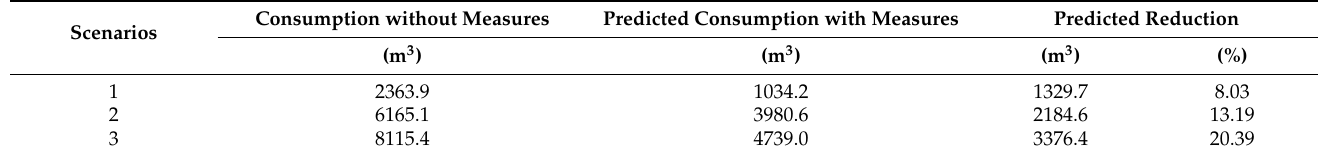
Table 4. Water consumption without and with water-saving